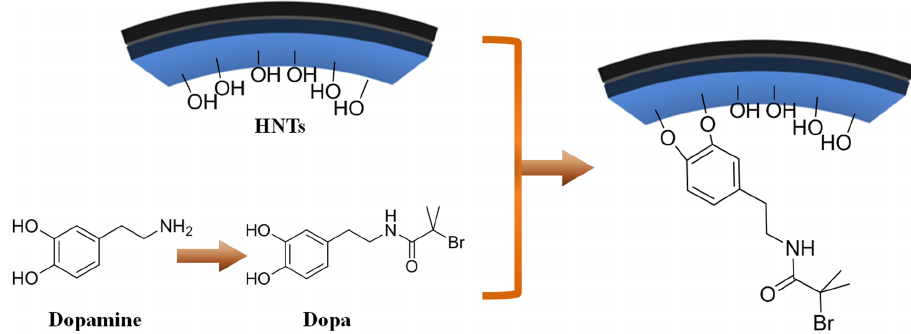
Figure 6: Dopamine derivative for selective modification of the inner surface of HNTs demonstrated by Takahara et al.